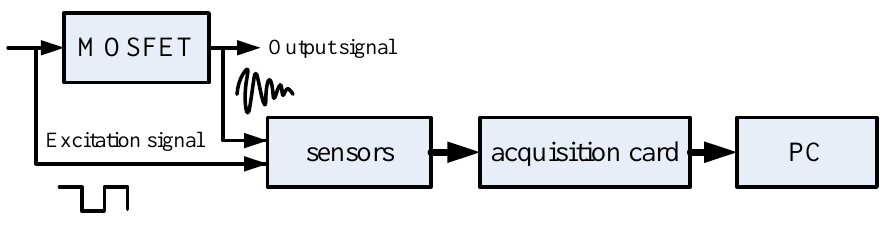
Figure 4. Diagram of the data acquisition process.